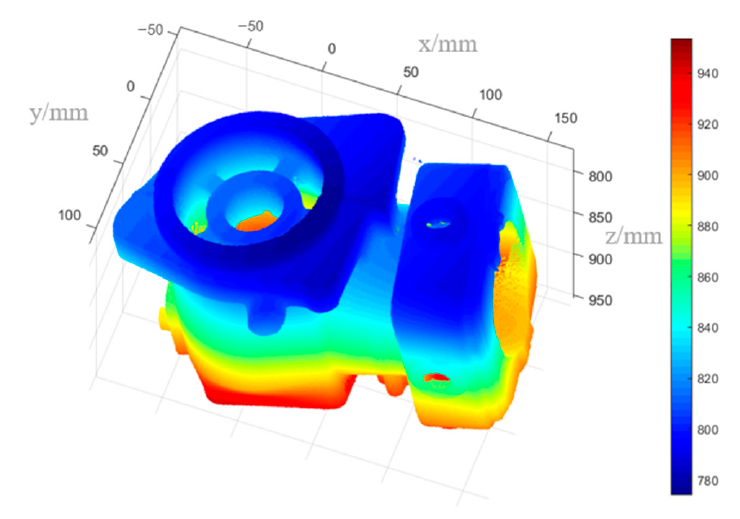
Figure 7. Complete point cloud diagram of casting.